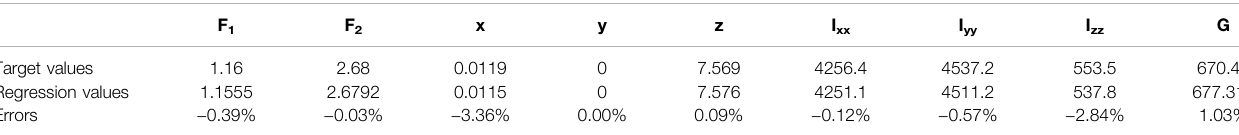
TABLE 6 | Simpli fi ed vibration model